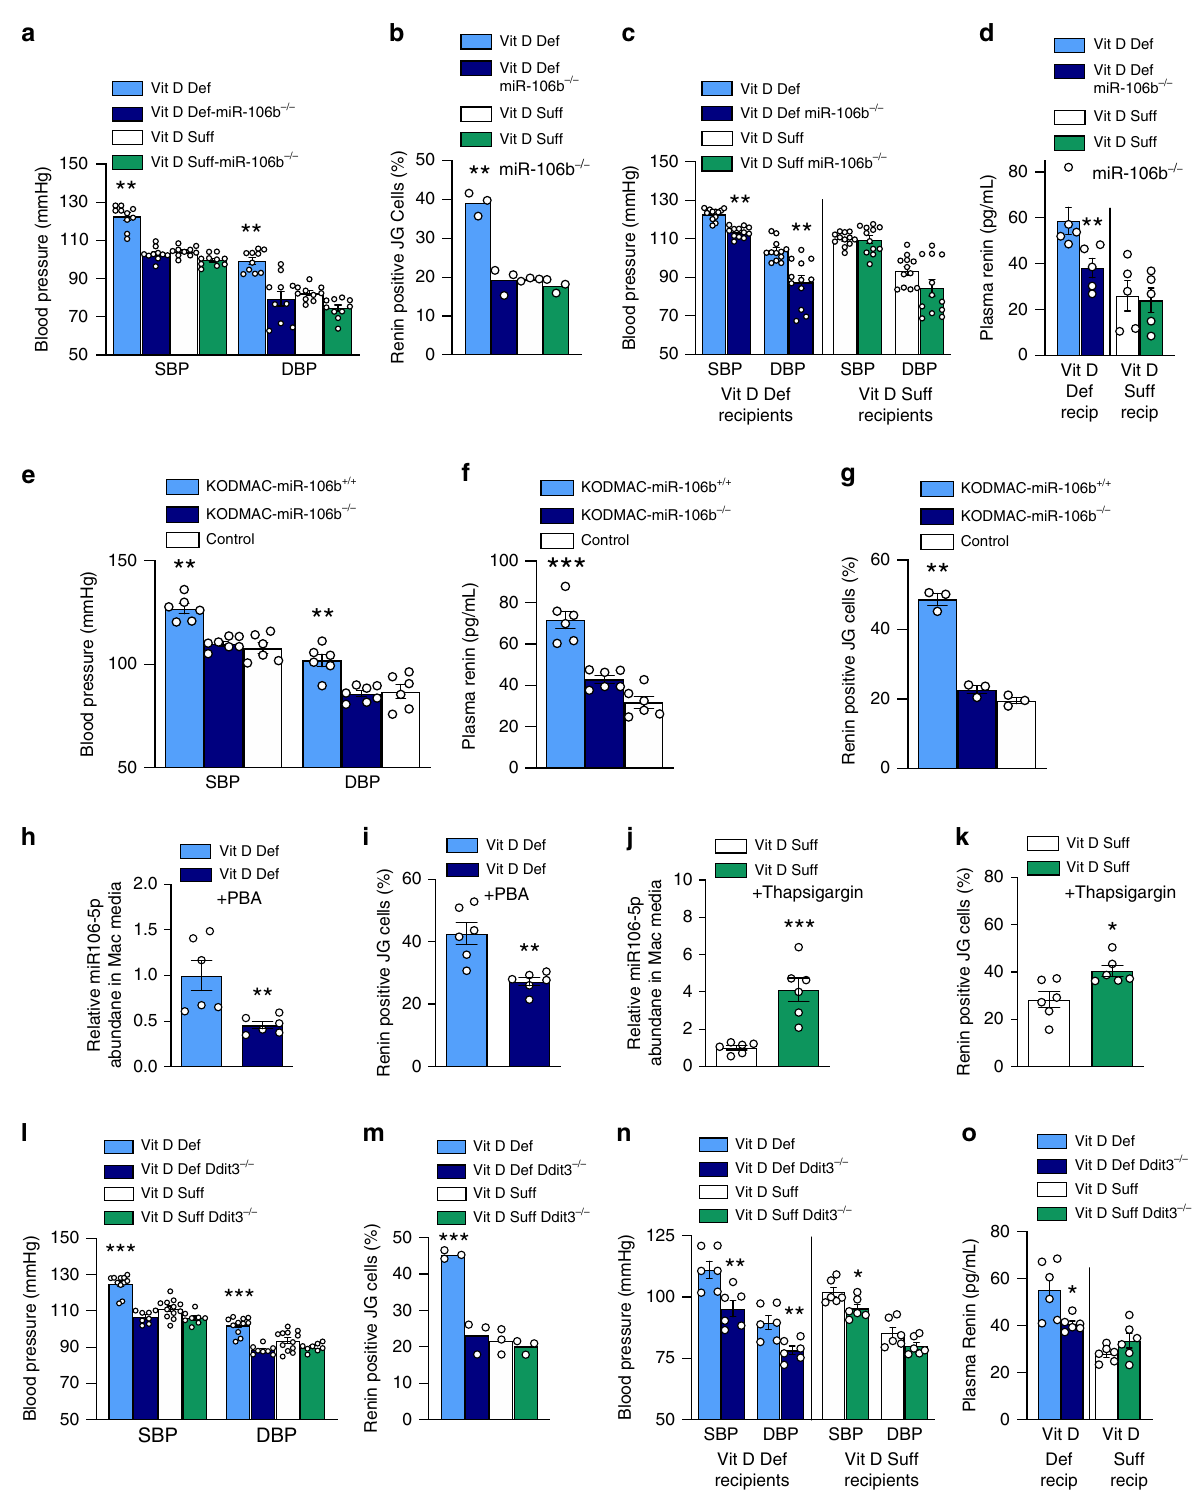
KODMAC media had decreased E2F1 and PDE3B protein expression, increased mRNA expression of Ppargc1a and Pparg , and increased the levels of cAMP, CREB, and phospho-CREB, suggesting that media miR-106b-5p is suf fi cient to repress the endogenous levels of E2F1 and PDE3B, increasing PPAR γ /CREB stimulation of JG cell renin production (Fig. 4c – e). To validate that E2f1 and Pde3b downregulation are critical to JG cell renin production, we knocked down E2f1 and Pde3b in JG cells